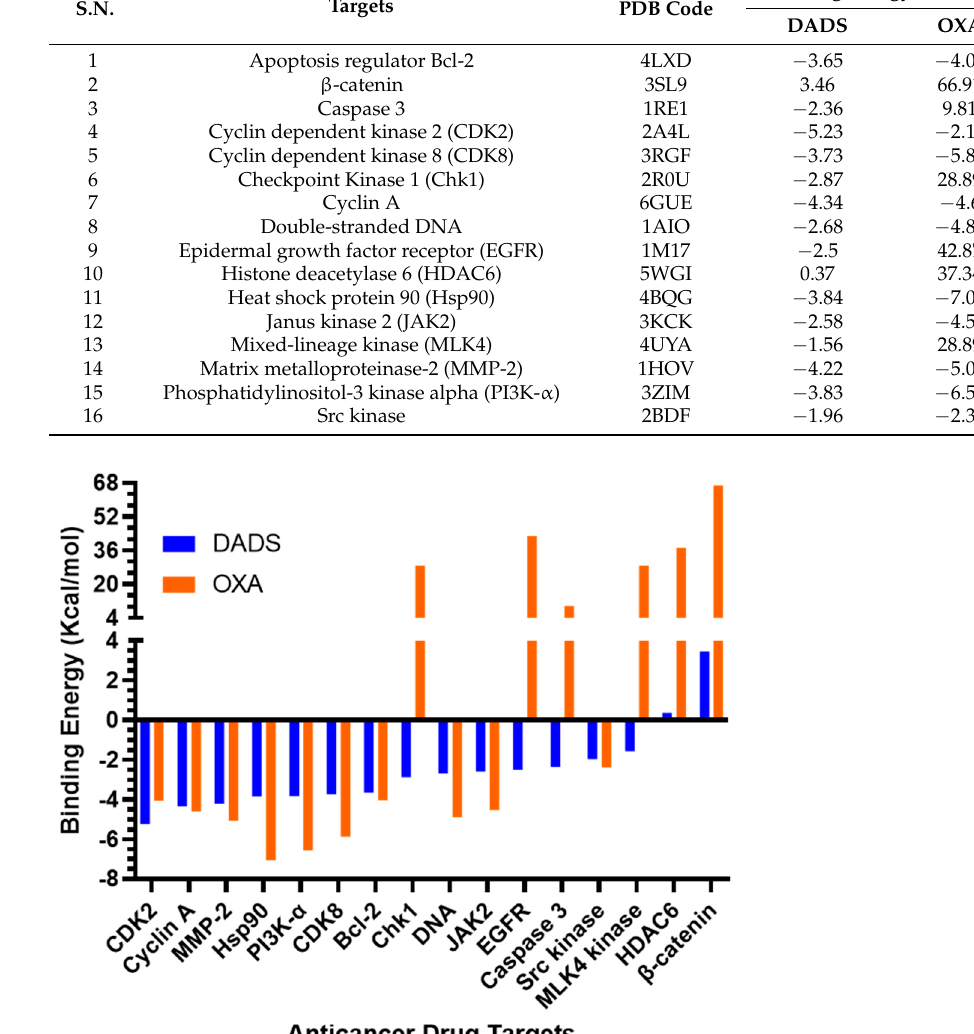
Figure 2. Docked compounds DADS and OXA, shown in blue and red color, respectively. Cyclin- dependent kinase 2 protein is in ribbon style, while docked ligands occupying the binding site are presented as CPK rendering ( A ). Minimum energy conformation of DADS ( B ) and OXA ( C ) are shown as ball and stick, while interacting residues are displayed as sticks. Intermolecular interac- tions are depicted as broken lines.